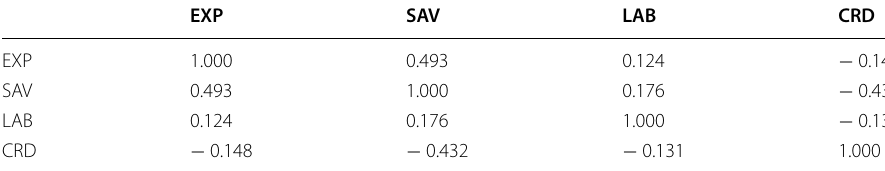
Table 5 Correlation